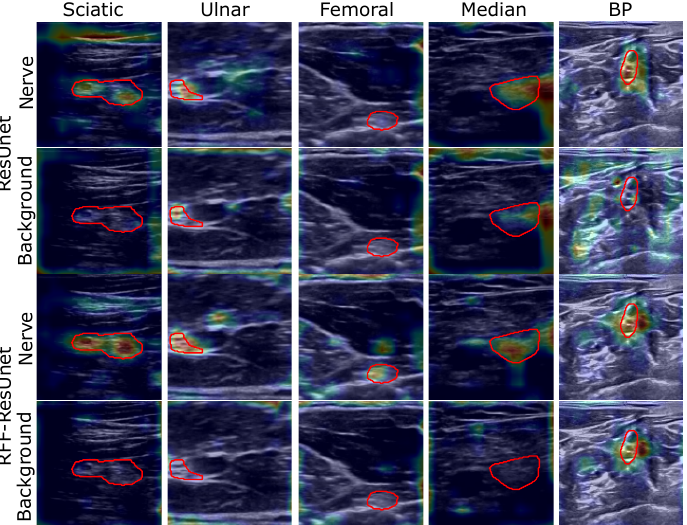
Figure 7. ResUnet and RFF-ResUnet relevance analysis results (illustrative examples are shown for the Nerve-UTP and NSD datasets). The class activation maps are shown in front of the input image (as an explanation map for visualization purposes)—red contour: target segmentation. Heatmaps are presented on a Jet colormap scale, where the blue color stands for low relevance, yellow for medium relevance, and red for high